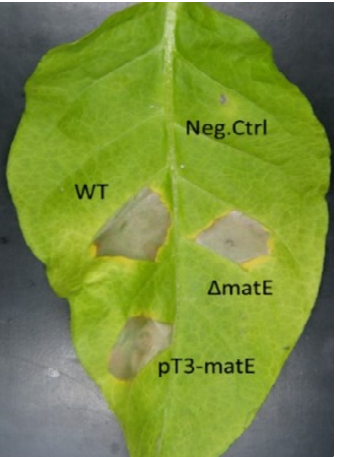
Figure 1. Hypersensitive Response assay on N. tabacum . Tobacco leaves were infiltrated with bacterial suspensions of Δ matE and pT3- matE mutants. For comparison, the wild-type Psn23 (WT) was also tested. As negative control, sterile physiological solution was used (Neg.Ctrl). Picture was taken 48 h post-infiltration. Conversely, strongly statistically significant differences were found between Psn23 and its mutants as far as the in vitro production of IAA is concerned. After 24 and 48 h of incubation at 26°C